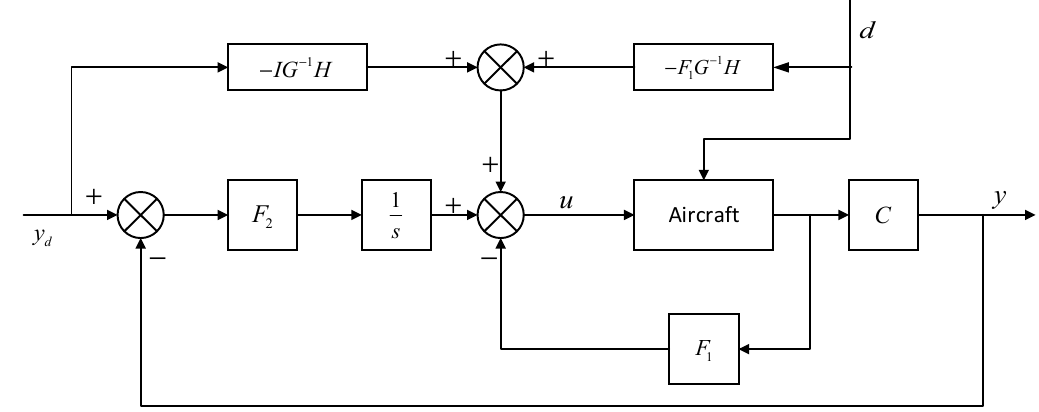
Figure 7. Block diagram of the linear quadratic regulator (LQR) feedforward closed-loop controller.